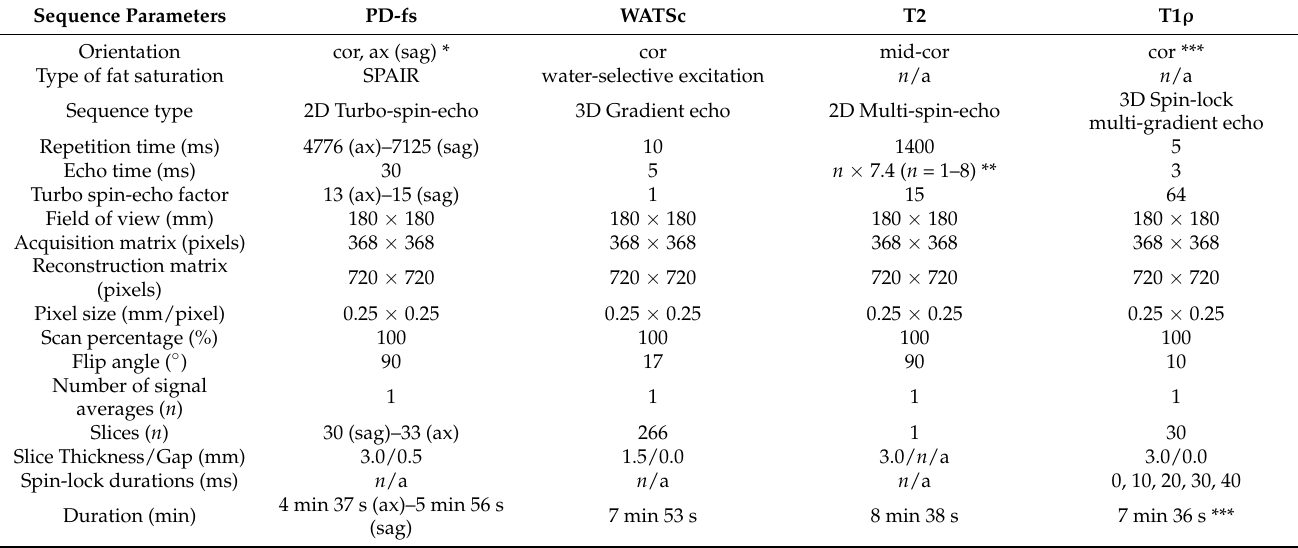
Table 1. Acquisition parameters of the MRI